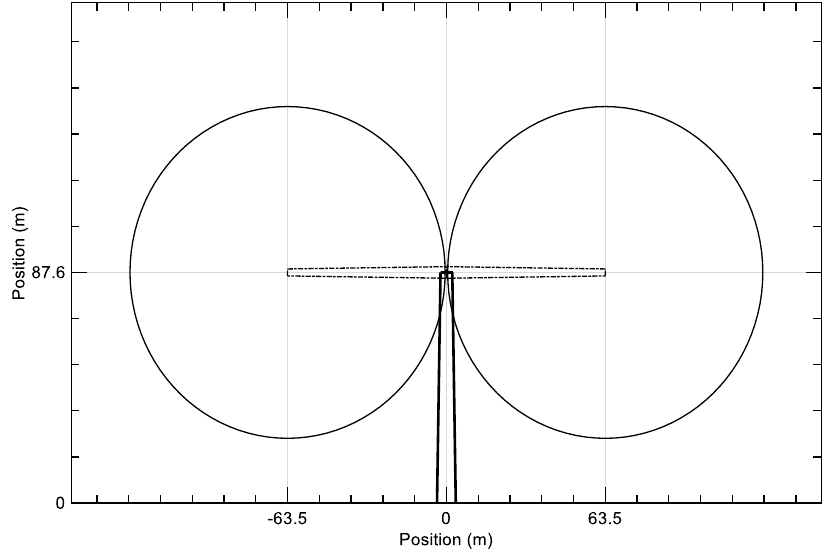
Figure 16. Sketch of the twin-rotor configuration.